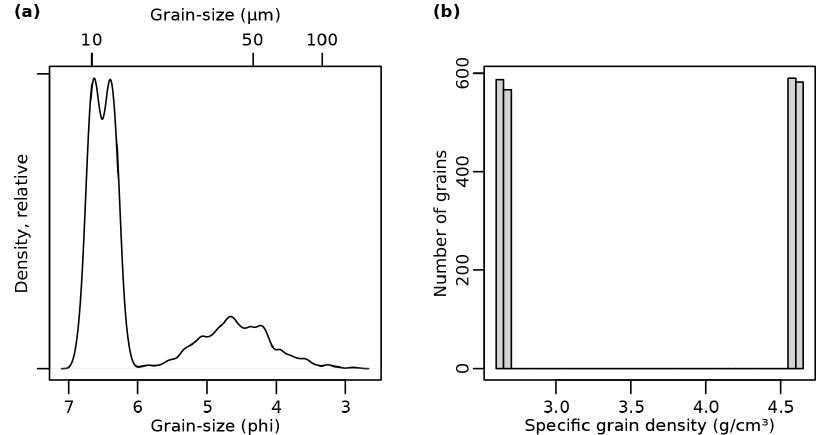
Figure 7. Properties of a virtual sample created at a depth of 11m from a rule book with both quartz and zircon grains (see the Supplement for details). (a) Grain-size distribution, dominated by narrow distributions (0.1 φ standard deviation) of a quartz end-member 1 (6.38 φ ) and an additional zircon population (6.65 φ ) as well as suppressed minor contributions of coarser quartz end-members. (b) Histogram of the specific grain densities of all grains, showing a roughly equal occurrence of the two dominant populations of quartz (2650kgm − 3 ) and zircon (4600kgm − 3